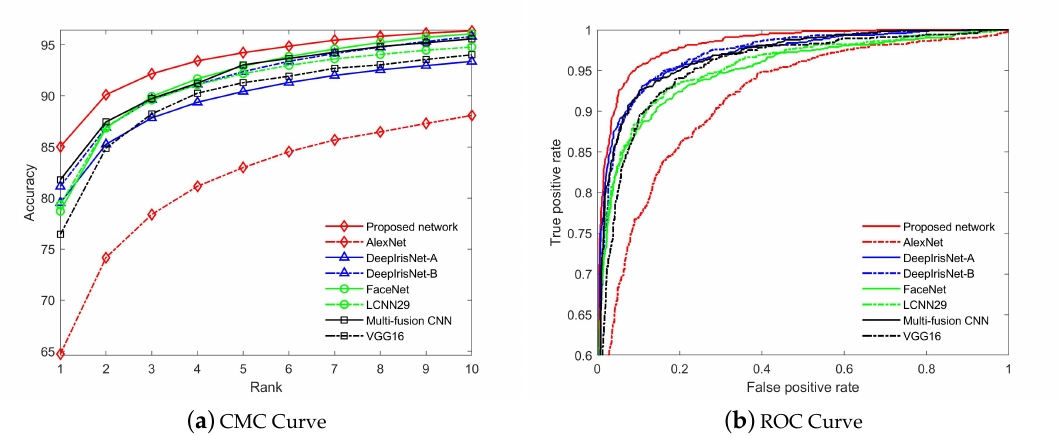
Figure 8. Performances of recognition and verification tasks on Ethnic-ocular database. The figures are the best to view in